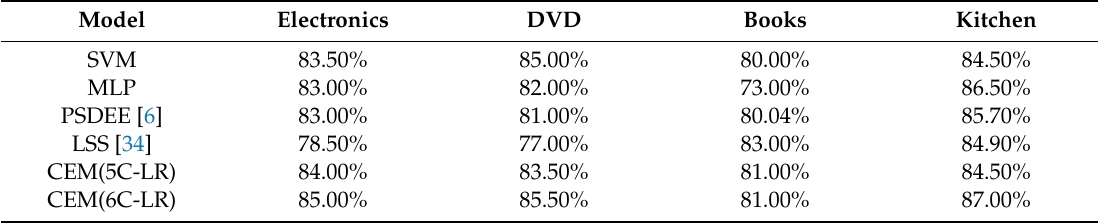
Table 7. Results experimented on four corpuses of Electronics, DVD, Books, and